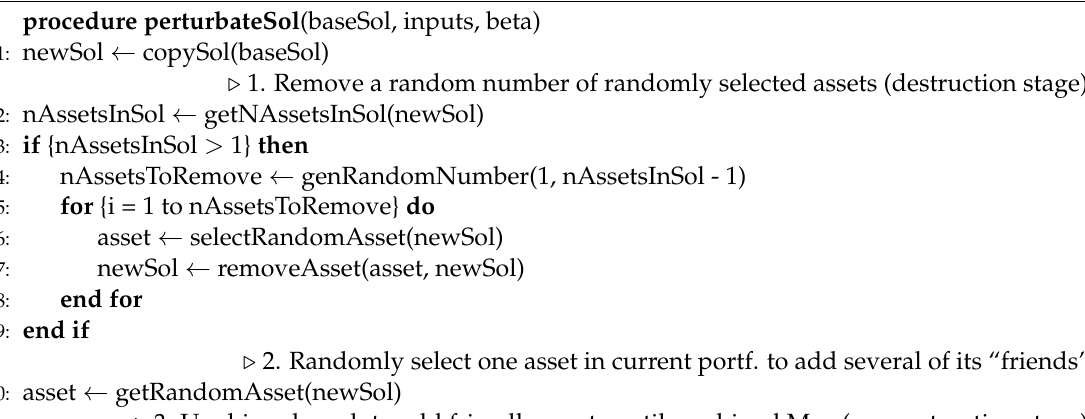
Algorithm 2 Perturbation procedure to generate new ‘promising’ solutions. procedure perturbateSol (baseSol, inputs, beta)